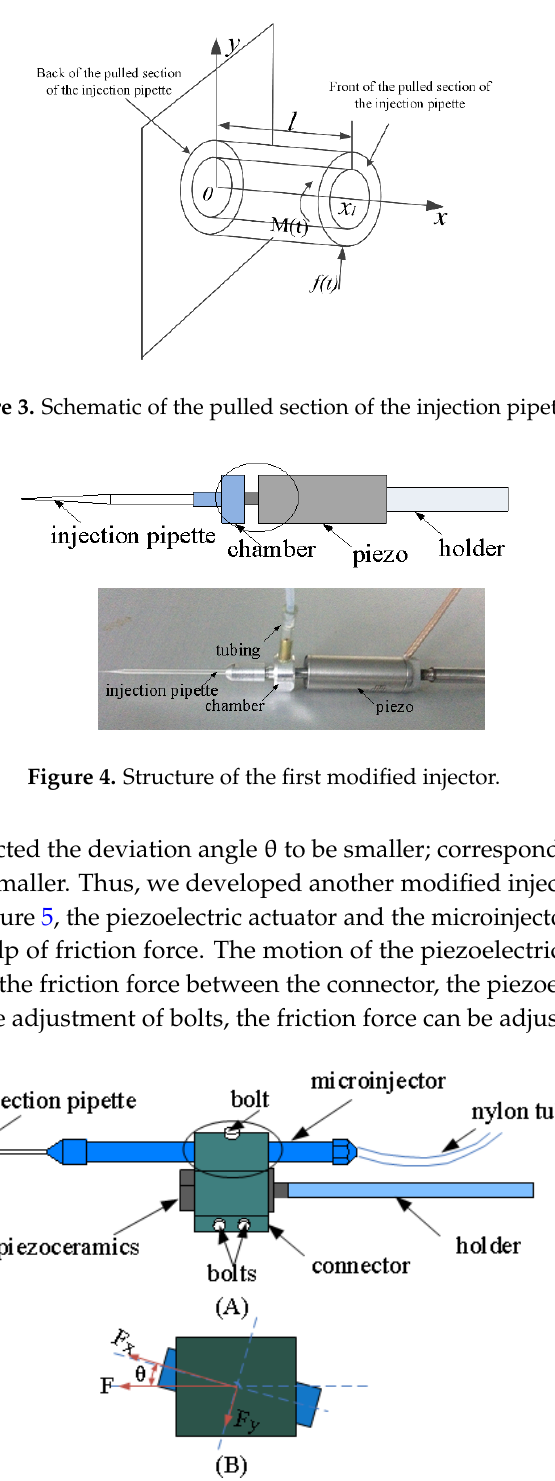
Figure 5. ( A ) Structure of the second modified injector. ( B ) Partial enlarged detail of the junction where the piezoelectric actuator is connected to the holders in the modified accessories.